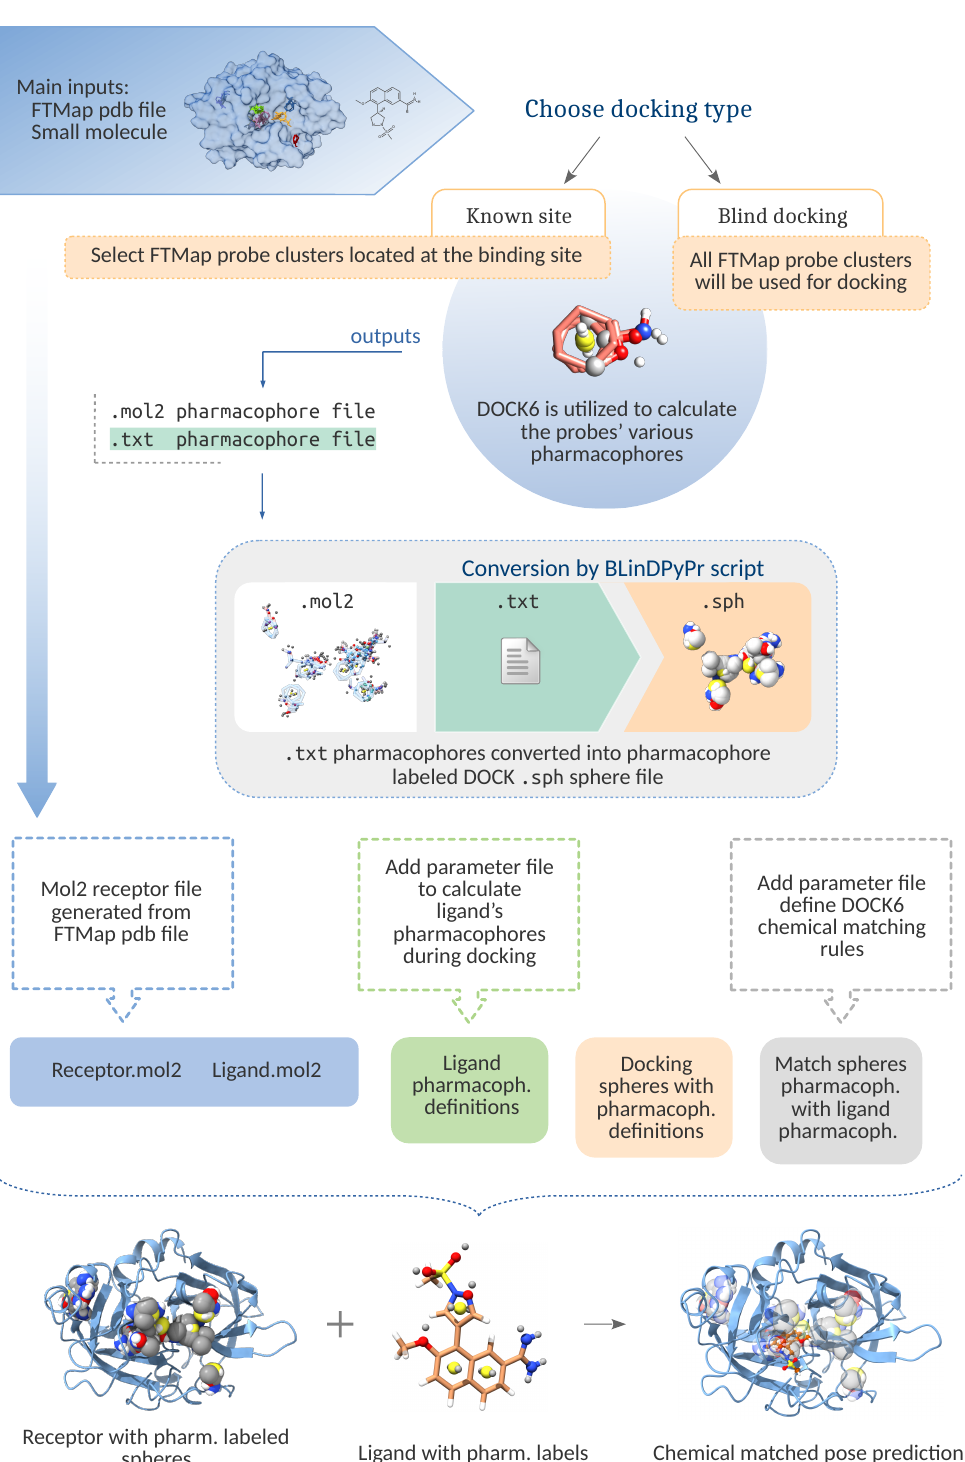
Figure 1. Schematic for the main conversion routine, which allows for multiple cavity guided blind docking with DOCK6. The figure also illustrates the chemical matching process which may be used to further orient the ligand. The docked probe crossclusters from FTMap PDB file are converted into mol2 format and fed to DOCK6 scoring function FMS to calculate pharmacophores. These are converted into the docking spheres necessary for a DOCK6 run, whose labels match the pharmacophores from which they were generated. If the user chooses not to perform chemical matching, BLinDPyPr will create a DOCK6 input with the chemical_matching flag turned